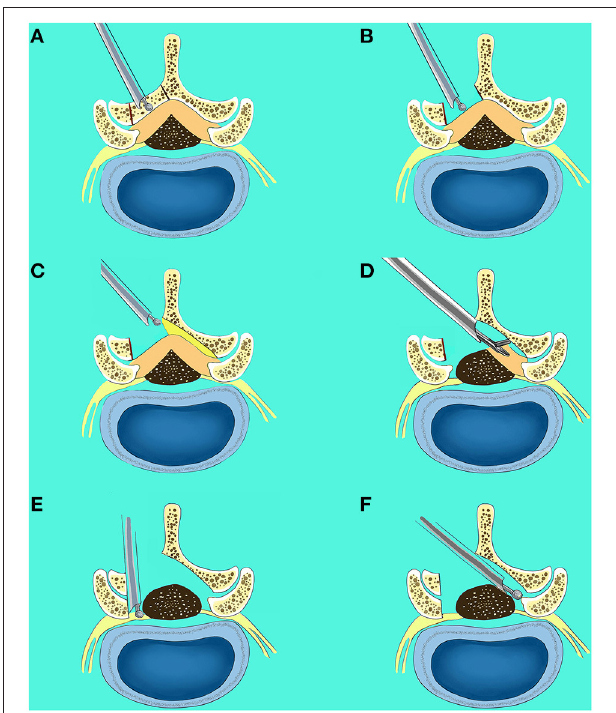
FIGURE 1 | Surgical procedures of lumbar endoscopic unilateral laminotomy bilateral decompression (LE-ULBD). (A,B) The inferior edge of the cranial lamina and the base of the spinous process of the ipsilateral side were removed by the endoscopic burr; (C) undercutting of the contralateral cranial lamina was performed; (D) the ipsilateral and contralateral ligamentum flavum was identified and removed piecemeal with endoscopic punches and forceps; (E) the ipsilateral medial facetectomy was performed to decompress the lateral recess and ensure adequate decompression of the traversing nerve root; (F) the contralateral medial facetectomy was performed to decompress the lateral recess and ensure adequate decompression of the traversing nerve root.